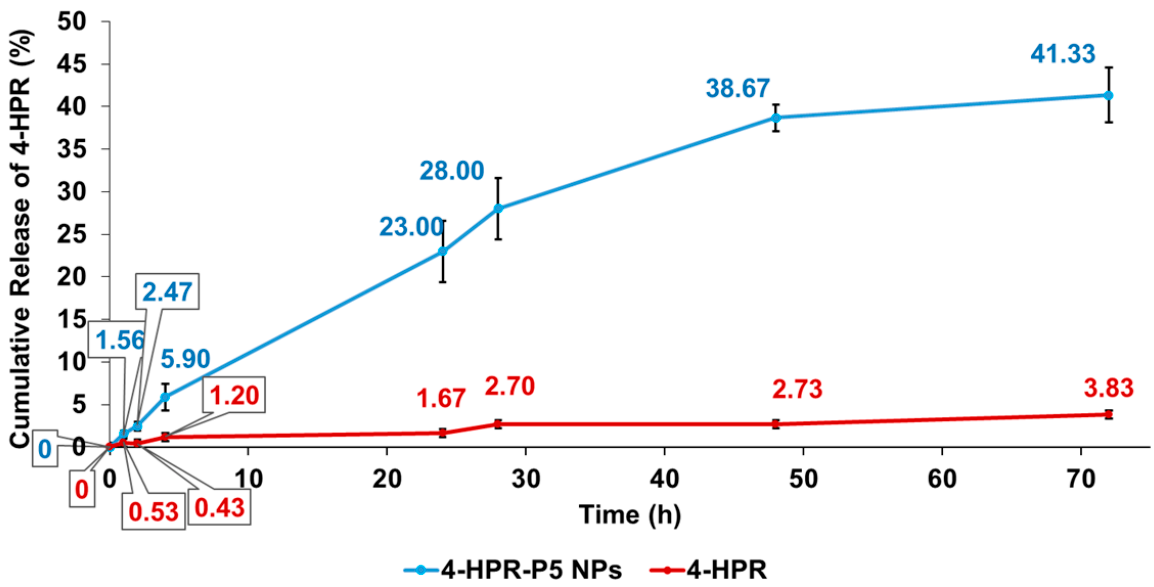
Figure 8. CR% of 4-HPR from NPs and from its suspension at pH 7.4, monitored for 72